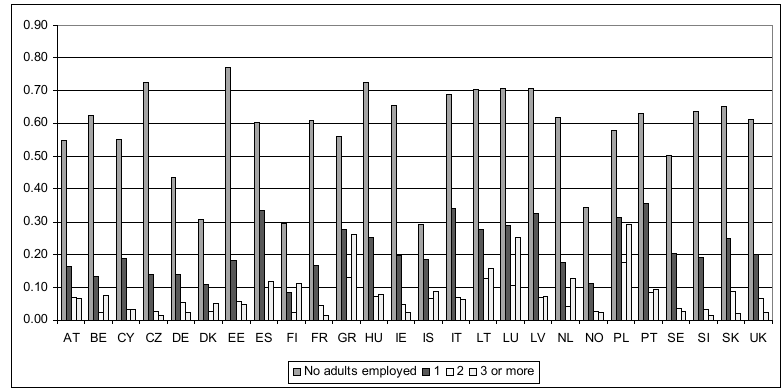
Figure 1 : Child poverty rate and total poverty rate. % living in households with income less than 60 per cent of the equivalent median 051015202530